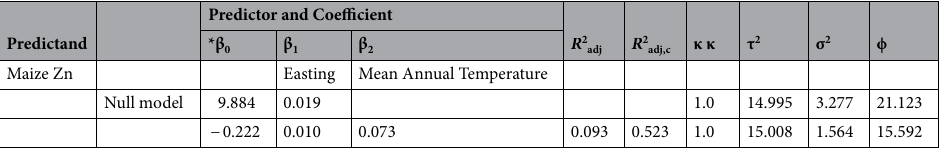
Table 5. Fitted models for environmental covariates and maize grain Zn concentration in Malawi. *β 0 –β 4 , fixed effects coefficients β 0 is a constant and β i is the coefficient for the i th random effect; R 2 adj , the difference between the sum of the variances of the random effects for the null model and the proposed model expressed as a proportion of the sum for the null model; R 2 adj,c , the difference between the variance of the correlated random effect (σ 2 ) for the null model and the proposed model expressed as a proportion of that variance for the null model; κ, smoothness parameter of the Matérn correlation function; τ 2 , variance of the iid random effect (nugget variance); σ 2 , variance of the correlated random effect; ϕ, distance parameter of the Matérn correlation function.